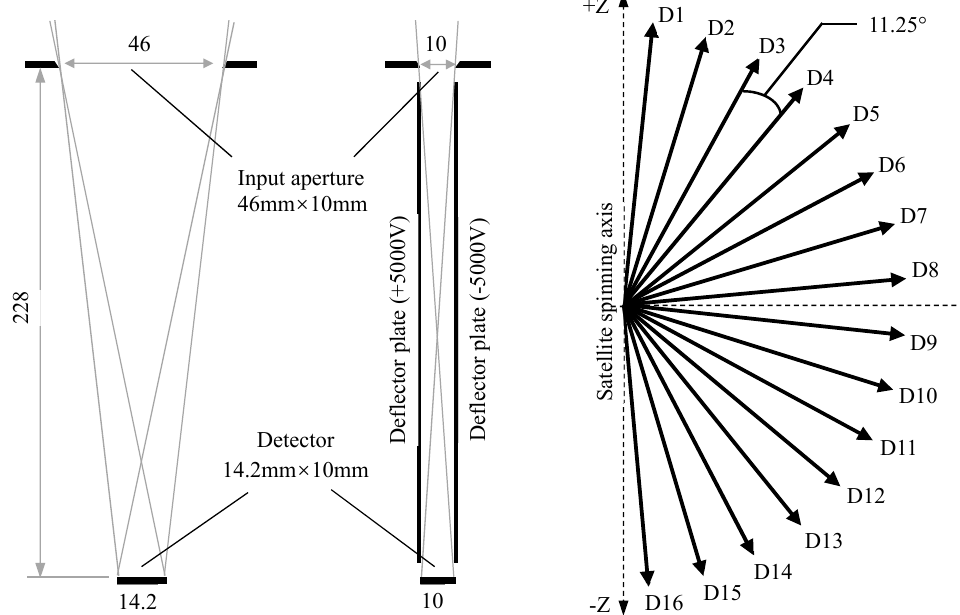
Figure 4. Field of view of a single detector and pointing directions of the detectors. By attitude control, the satellite spinning axis was usually maintained in vicinity of the Z axis of the Solar Magnetic (SM) coordinate system with +Z pointing northward.